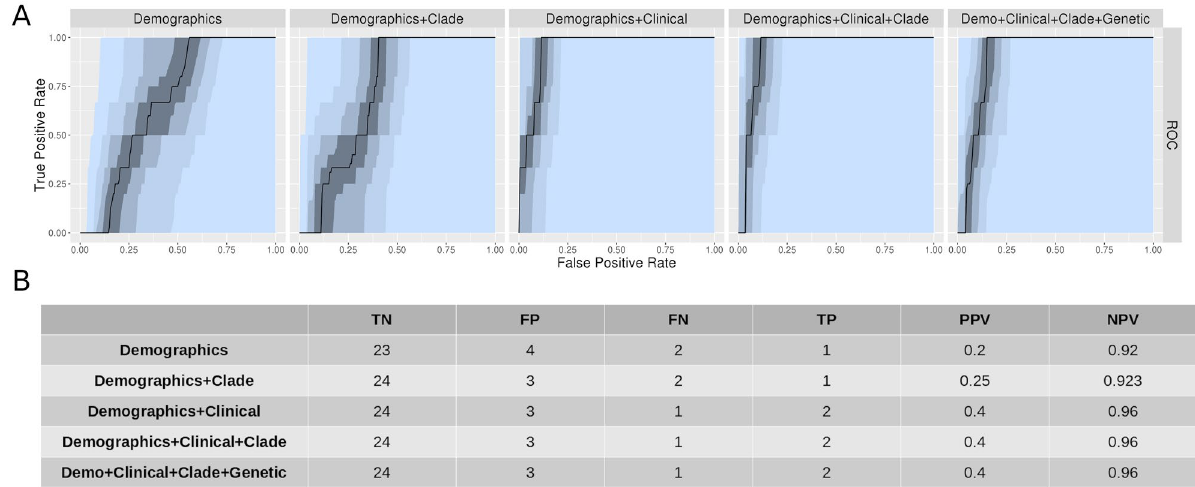
Figure 3. AUROC for machine learning models for prediction of hospitalization using test set of 30 most recent cases. Bottom: Optimal model performance for each dataset model for prediction of